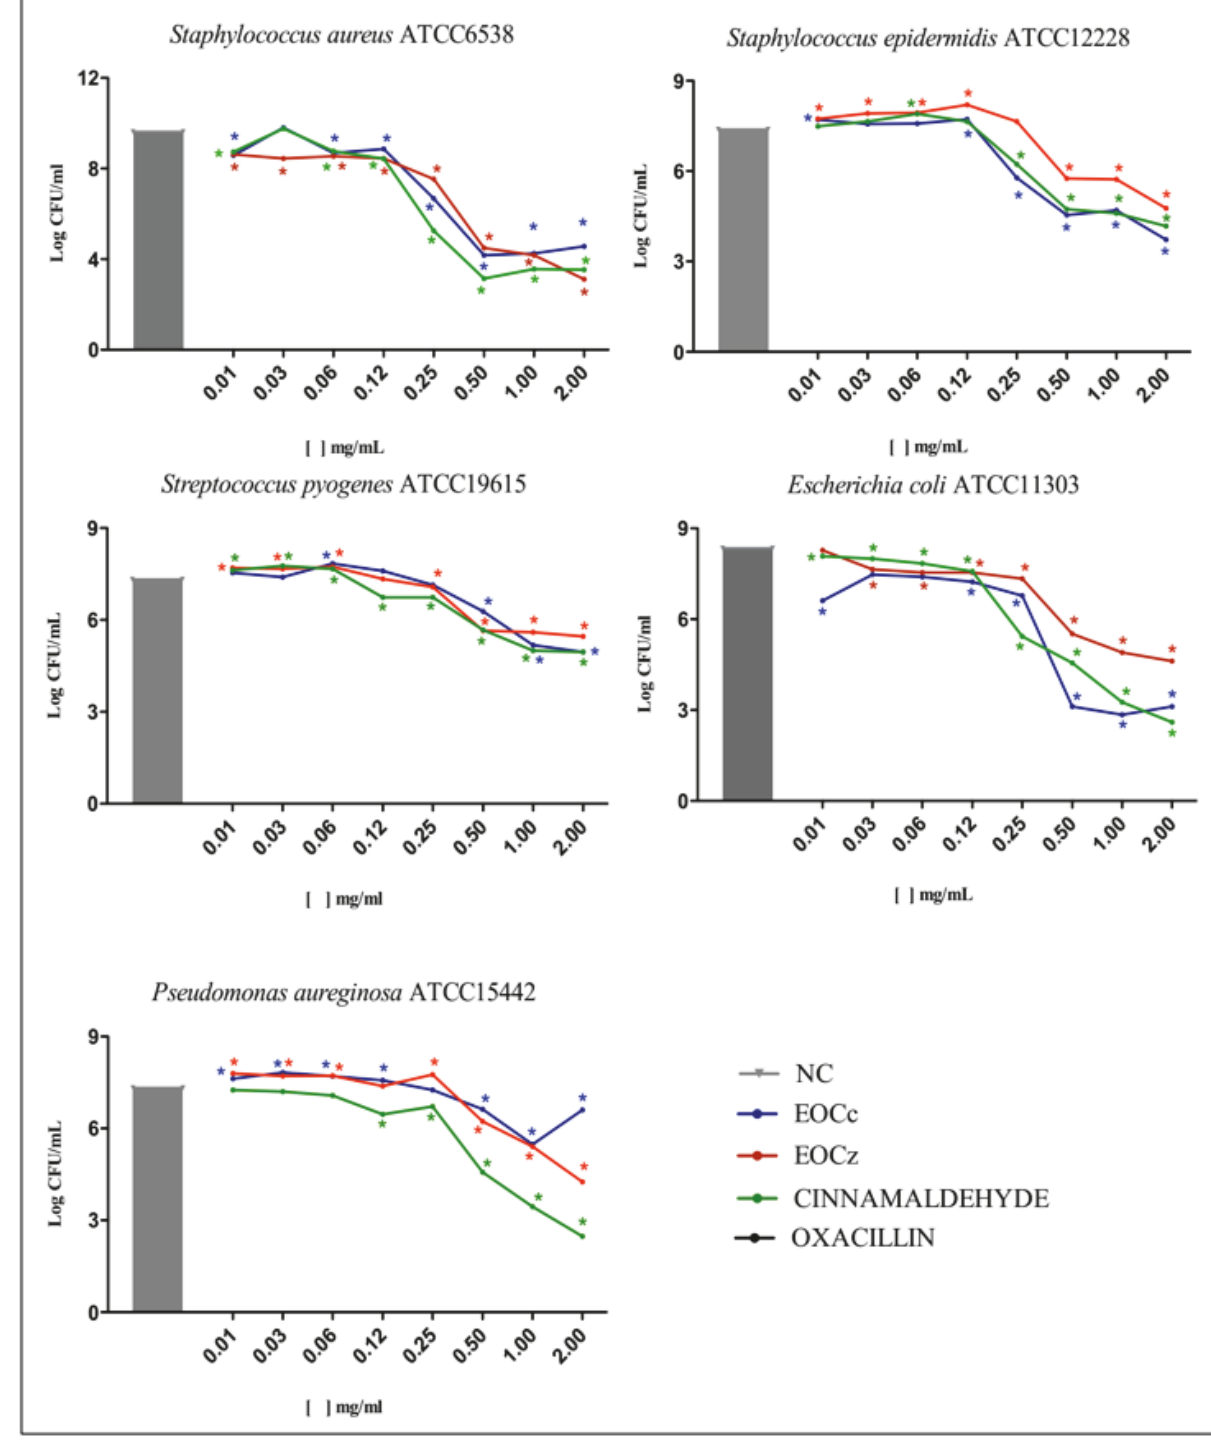
Figure 3: Cell viability in bacterial biofilms after the action of the essential oils from C. cassia and C. zeylanicum stems, cinnamaldehyde and oxacillin (mg/ml). ∗ p < 0.01. NC: negative control; EOCc: essential oil Cinnamomum cassia ; EOCz: essential oil Cinnamomum zeylanicum